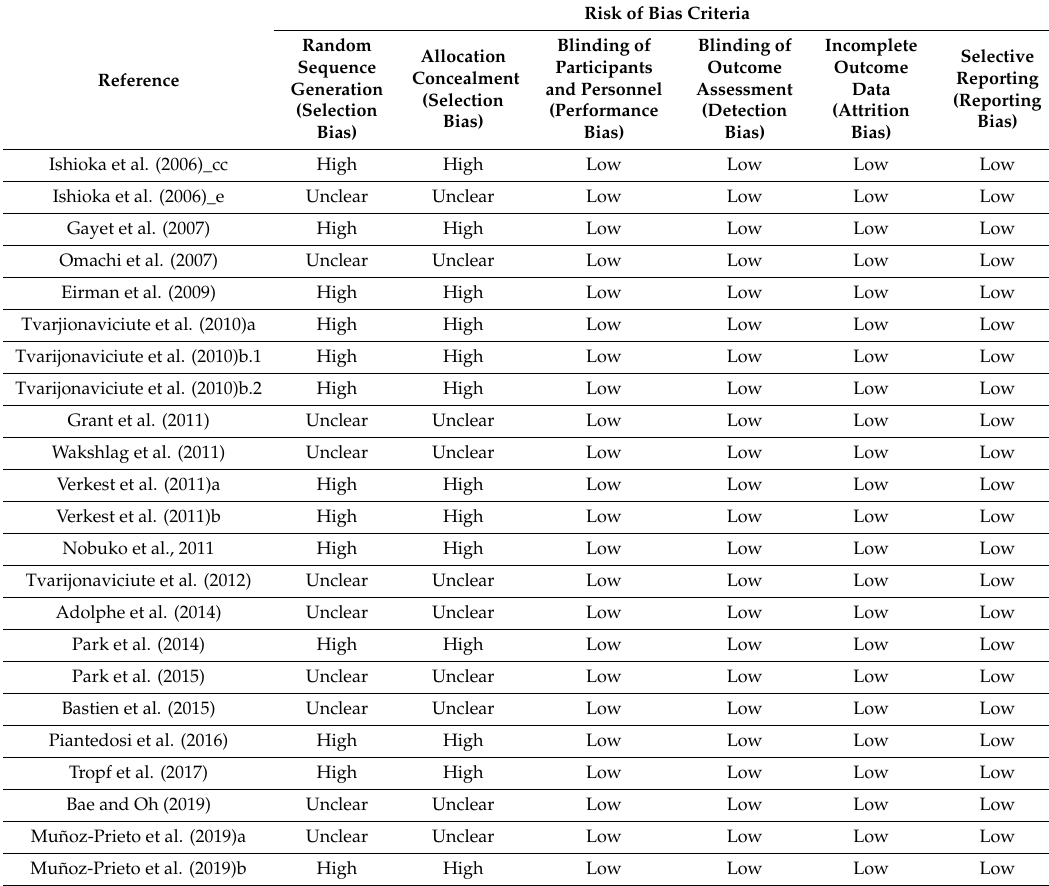
Table 4. Risk of bias for the studies include in the